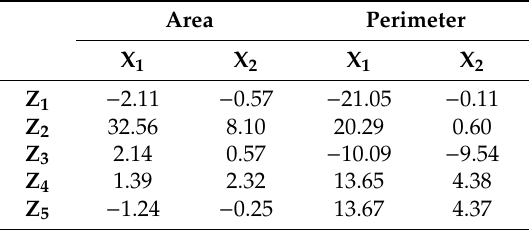
Table 7. Input weight for area and perimeter features.